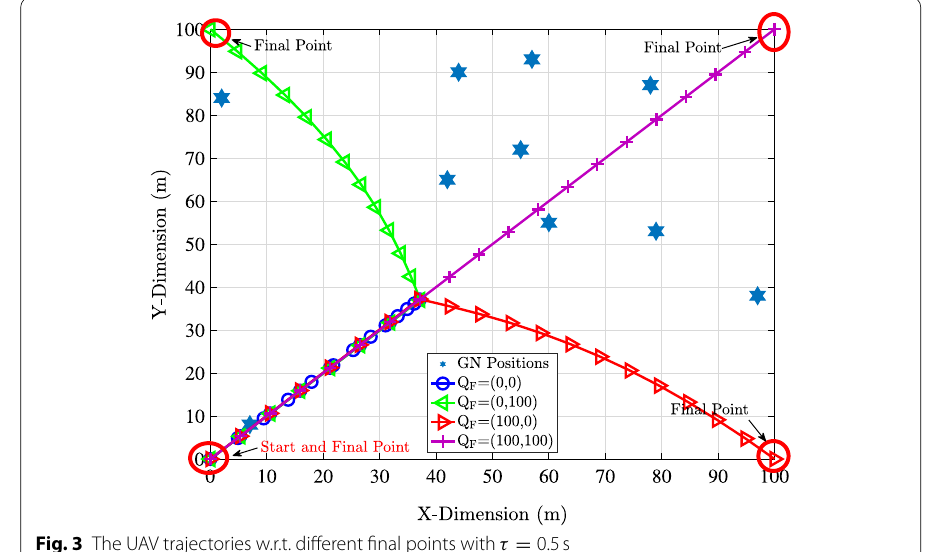
Fig. 3 The UAV trajectories w.r.t. different final points with τ = 0.5 s